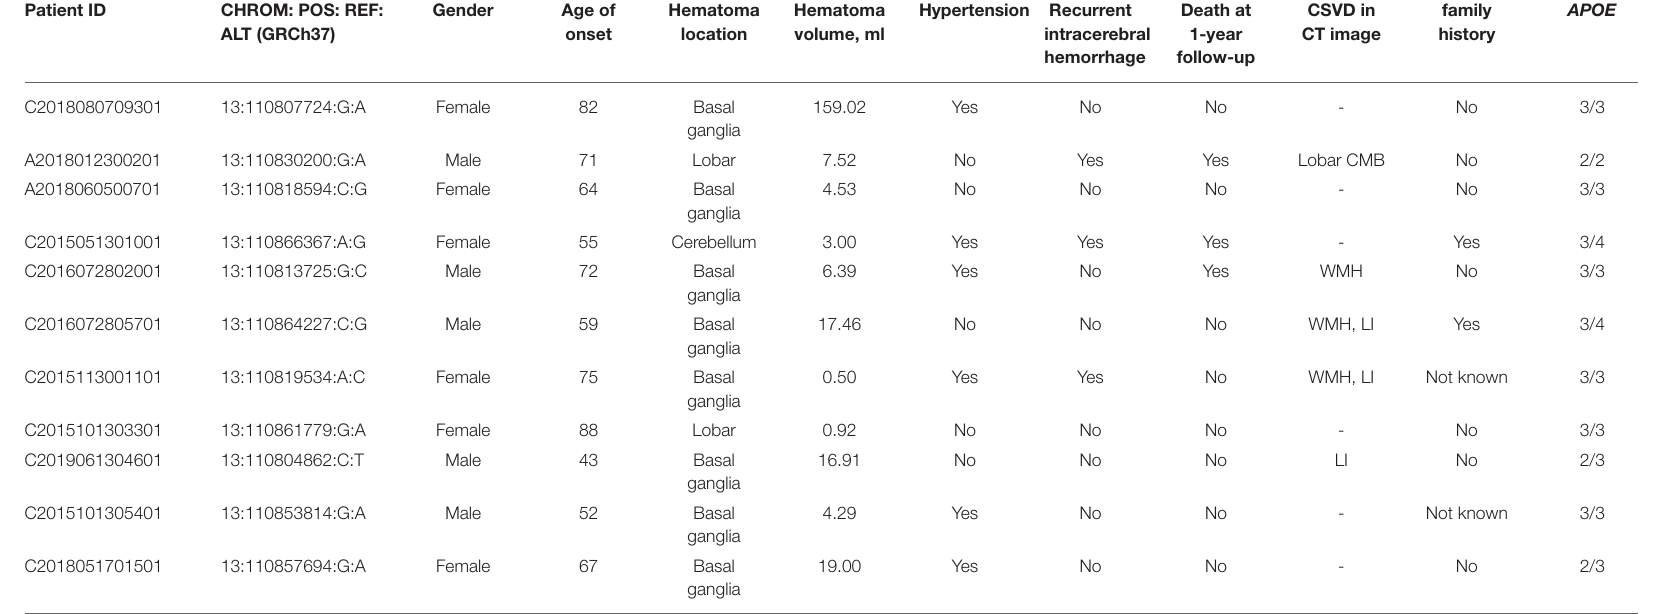
TABLE 3 | Clinical information of the ICH patients with rare variants in COL4A1 absent in controls. Patient